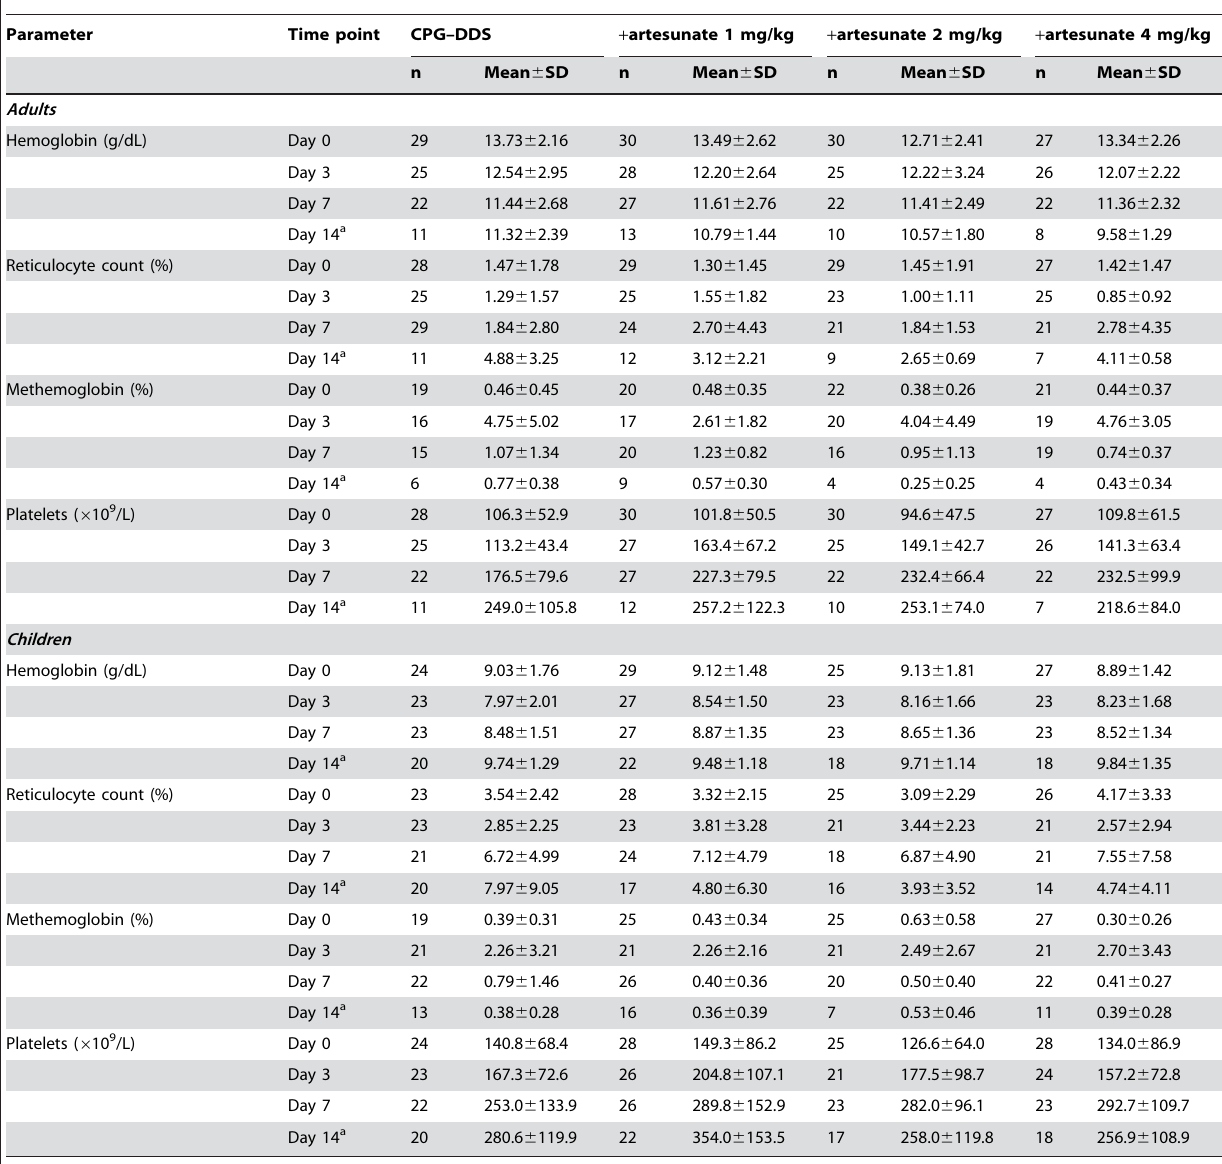
Table 6. Blood parameters where significant changes were observed during treatment for the intent to treat (safety) population.